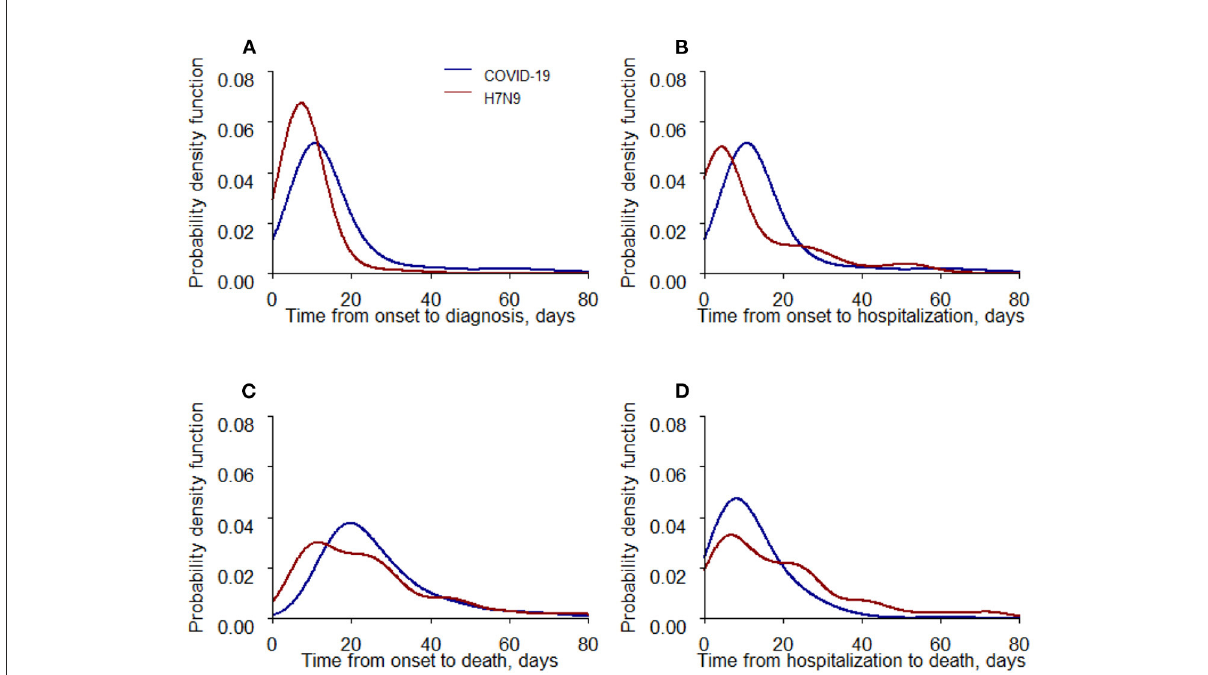
FIGURE1 Time-to-event distributions of COVID-19 and H7N9 fatal cases. (A) Days from illness onset to diagnosis. (B) Days from illness onset to hospital admission. (C) Days from illness onset to death. (D) Days from hospital admission to death.